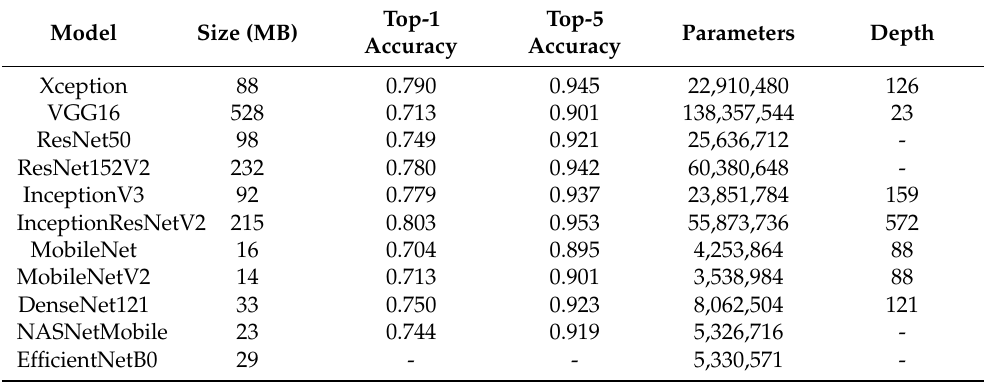
Table 1. Popular Deep learning models trained on ImageNet for classification. Top-1 Model Size (MB)